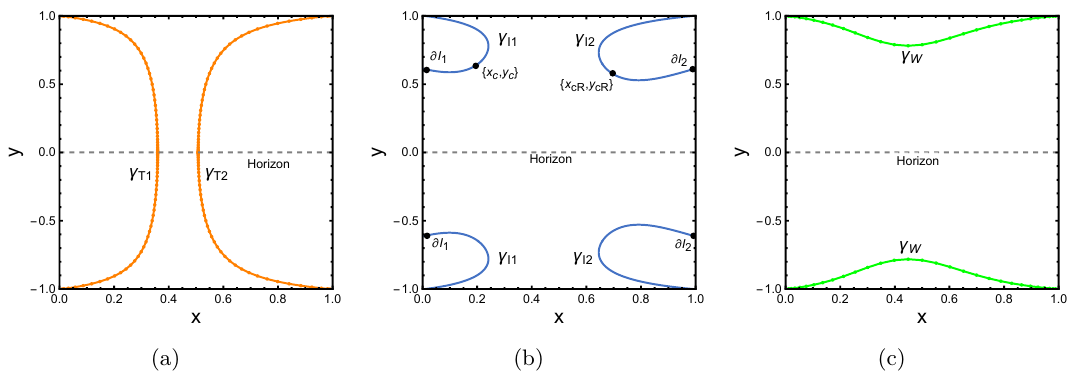
Figure 6 . The extremal surface in (a): trivial phase, (b): island phase and (c): wormhole phase with { L, θ = { 1 , π/ 4 , π/ 5 , 1 , 1 , 1 , 1 / 2 } . Note that the minus sign in y -direction 1 , θ 2 , λ 1 , λ 2 , µ, w 0 } represents another asymptotic region, and is just convenient for drawing